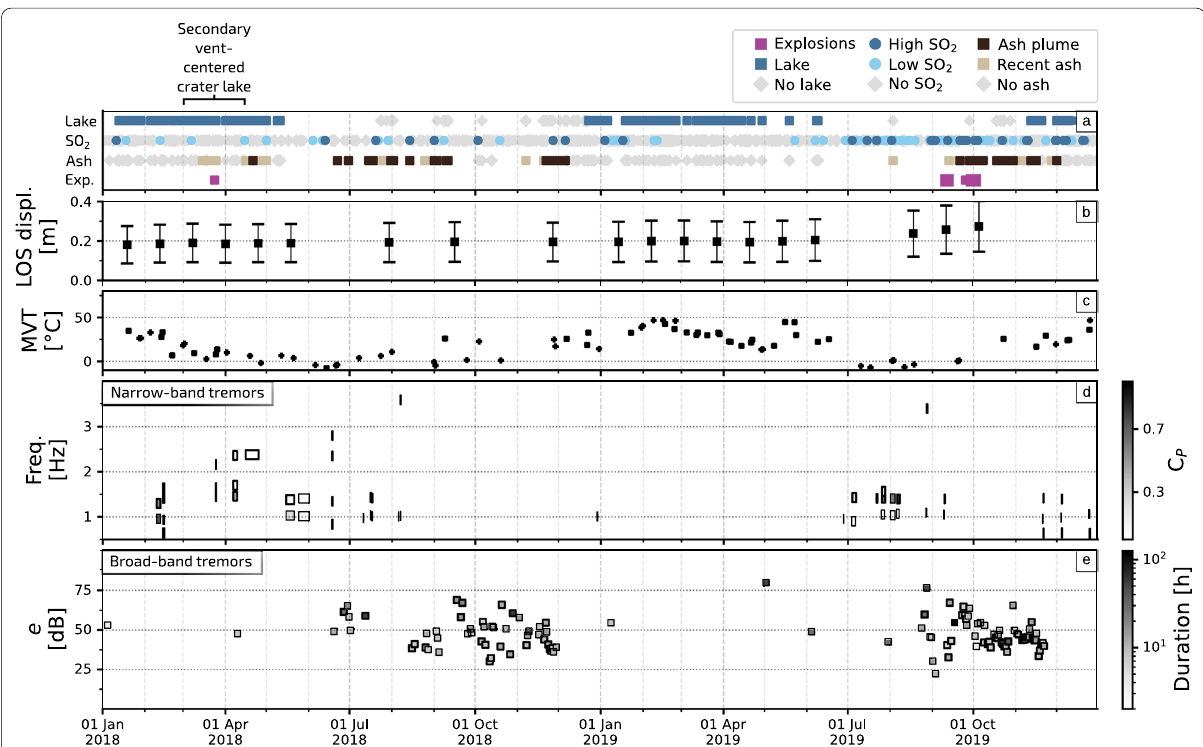
Fig. 12 Time evolution of a surficial activity, b LOS-displacement, c LST temperature, d frequency and C P of dominant frequencies of NB tremors, and e energy of BB tremors for the periods January 2018 to December 2019. Gray shadows in c and d depict periods without seismic